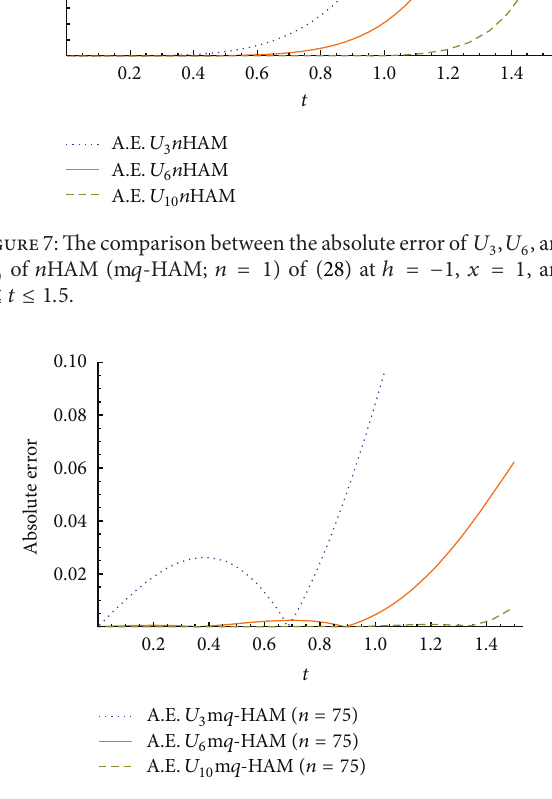
Figure8:Thecomparisonbetweentheabsoluteerrorof 𝑈 3 , 𝑈 6 ,and 𝑞 -HAM (𝑛 = 75) of (28) at ℎ = −49.25 , 𝑥 = 1 , and 0 ≤ 𝑡 ≤ 𝑈 10 of m 1.5